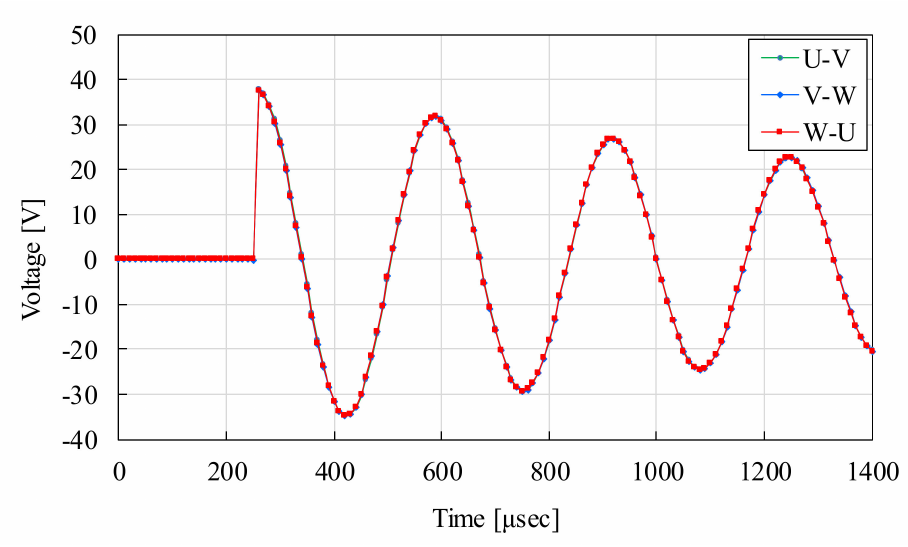
Figure 4. Waveform of a healthy winding.